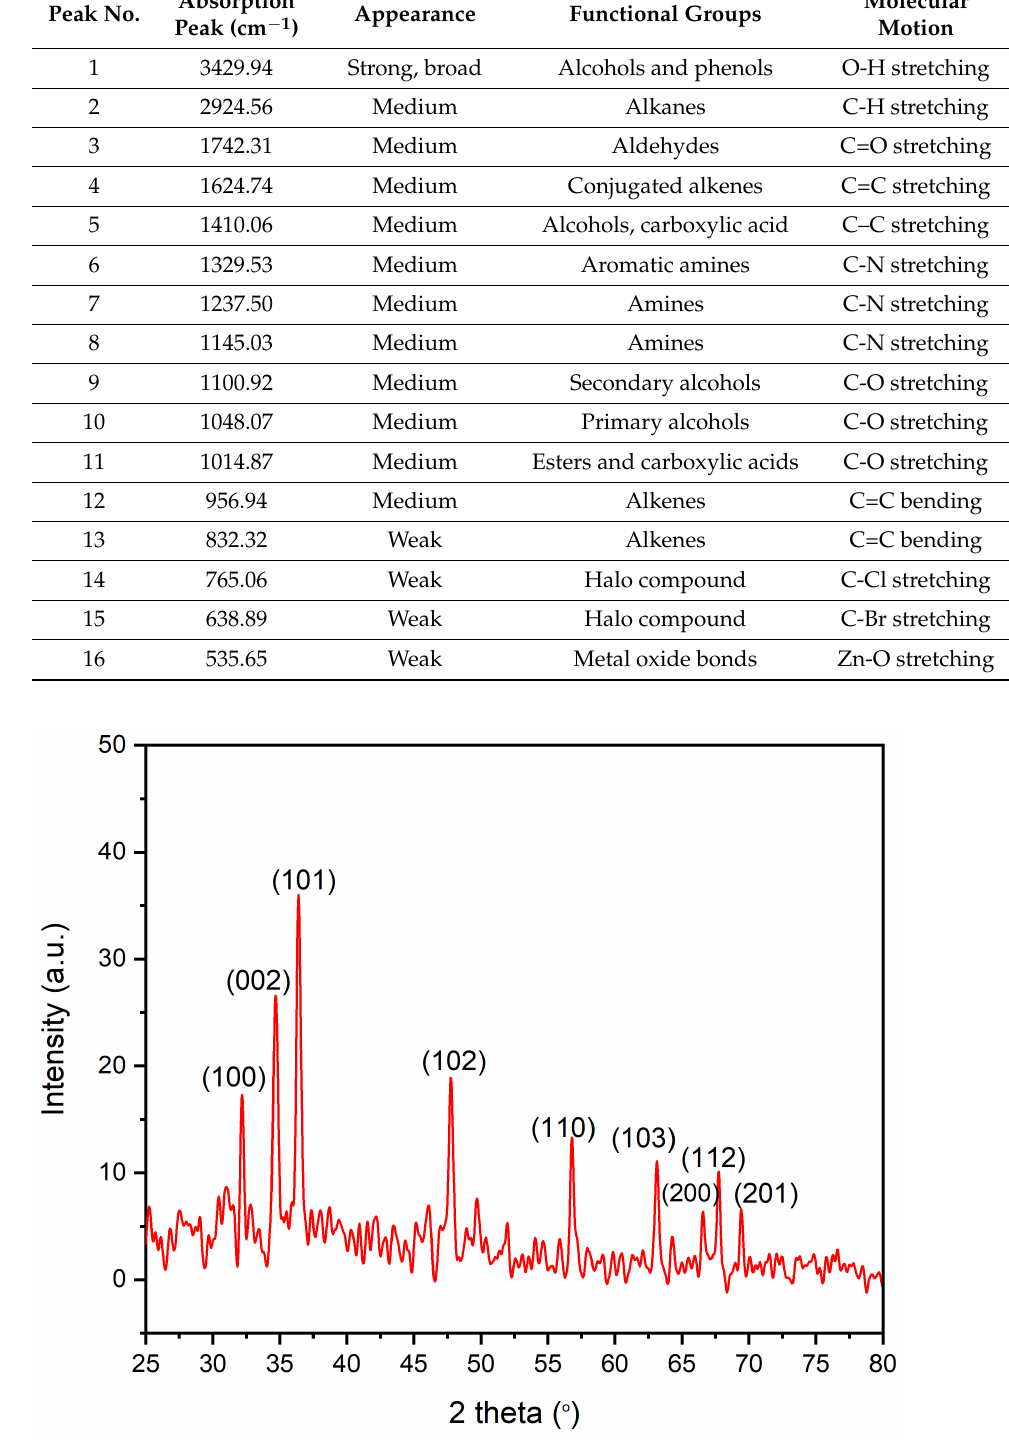
Figure 9. XRD pattern of